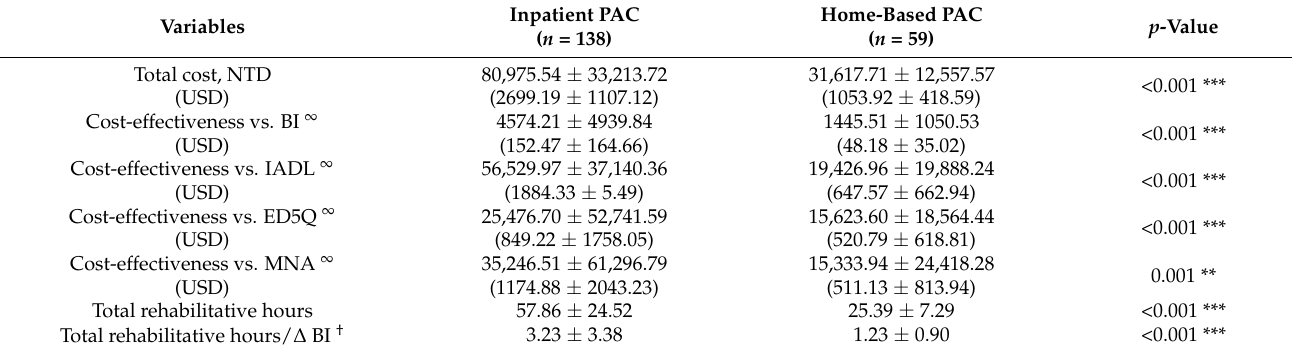
Table 4. Cost-effectiveness, rehabilitative hours and health economics of the inpatient and home-based PAC groups.